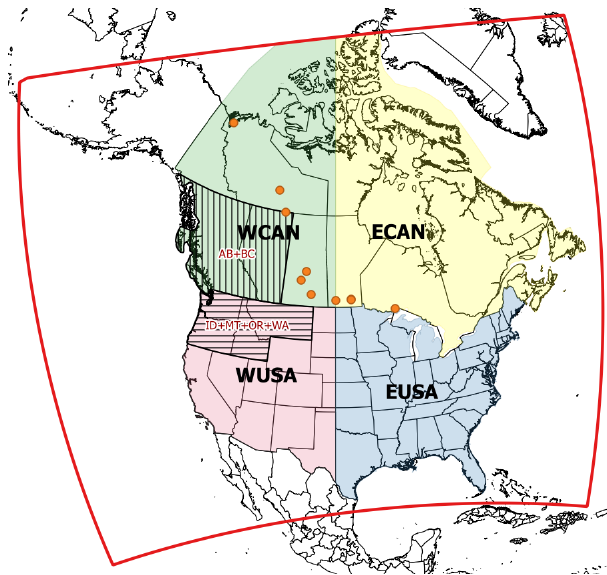
Figure 1. The boundary of the FireWork and RAQDPS domain is indicated by the red outline. The four continental subregions (ECAN, EUSA, WCAN, WUSA) considered for model perfor- mance evaluation are denoted by different colours. The spatial ex- tent of AB + BC and ID + MT + OR + WA, the two wildfire source regions used for model performance evaluation, are indicated by different diagonal hatching. The locations of the 10 AQ measure- ment stations in the northern Canada region are marked by orange dots (see also Table